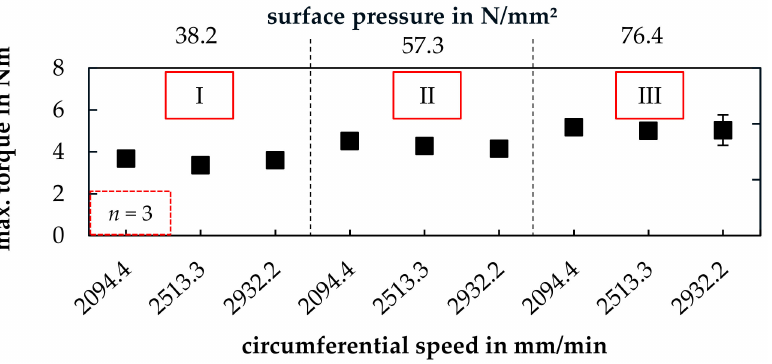
Figure 7. Influence of the welding process parameters on the occurring maximum torque—used tool (Ø10